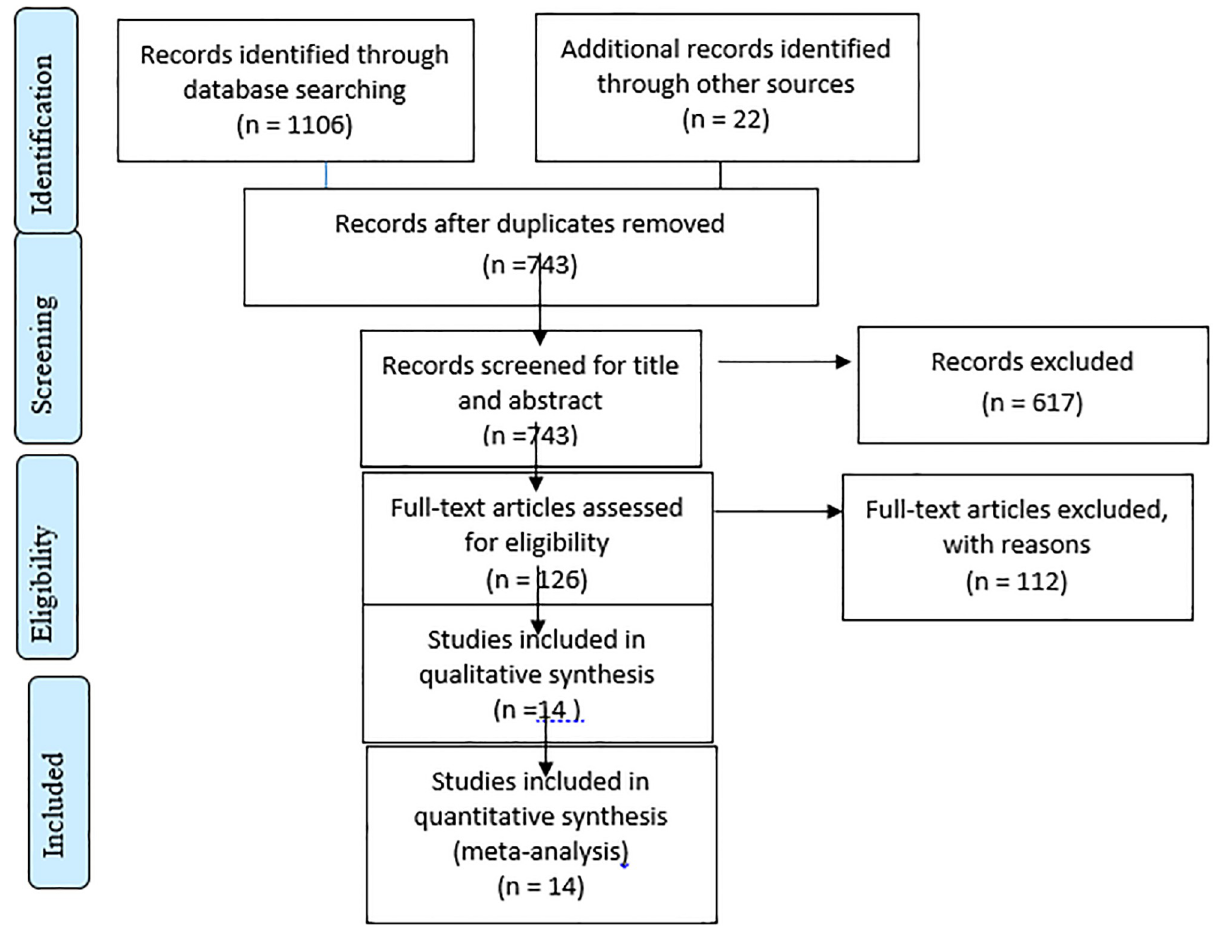
Fig 1. Flow chart illustrating the process of search and selection of studies included in the present systematic review and meta-analysis.